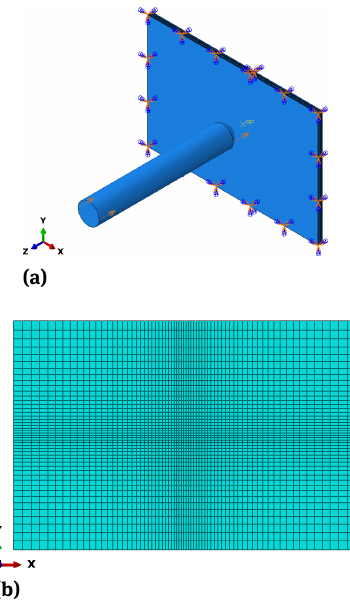
Figure 3: Finite element model (a) boundary condition (b) model